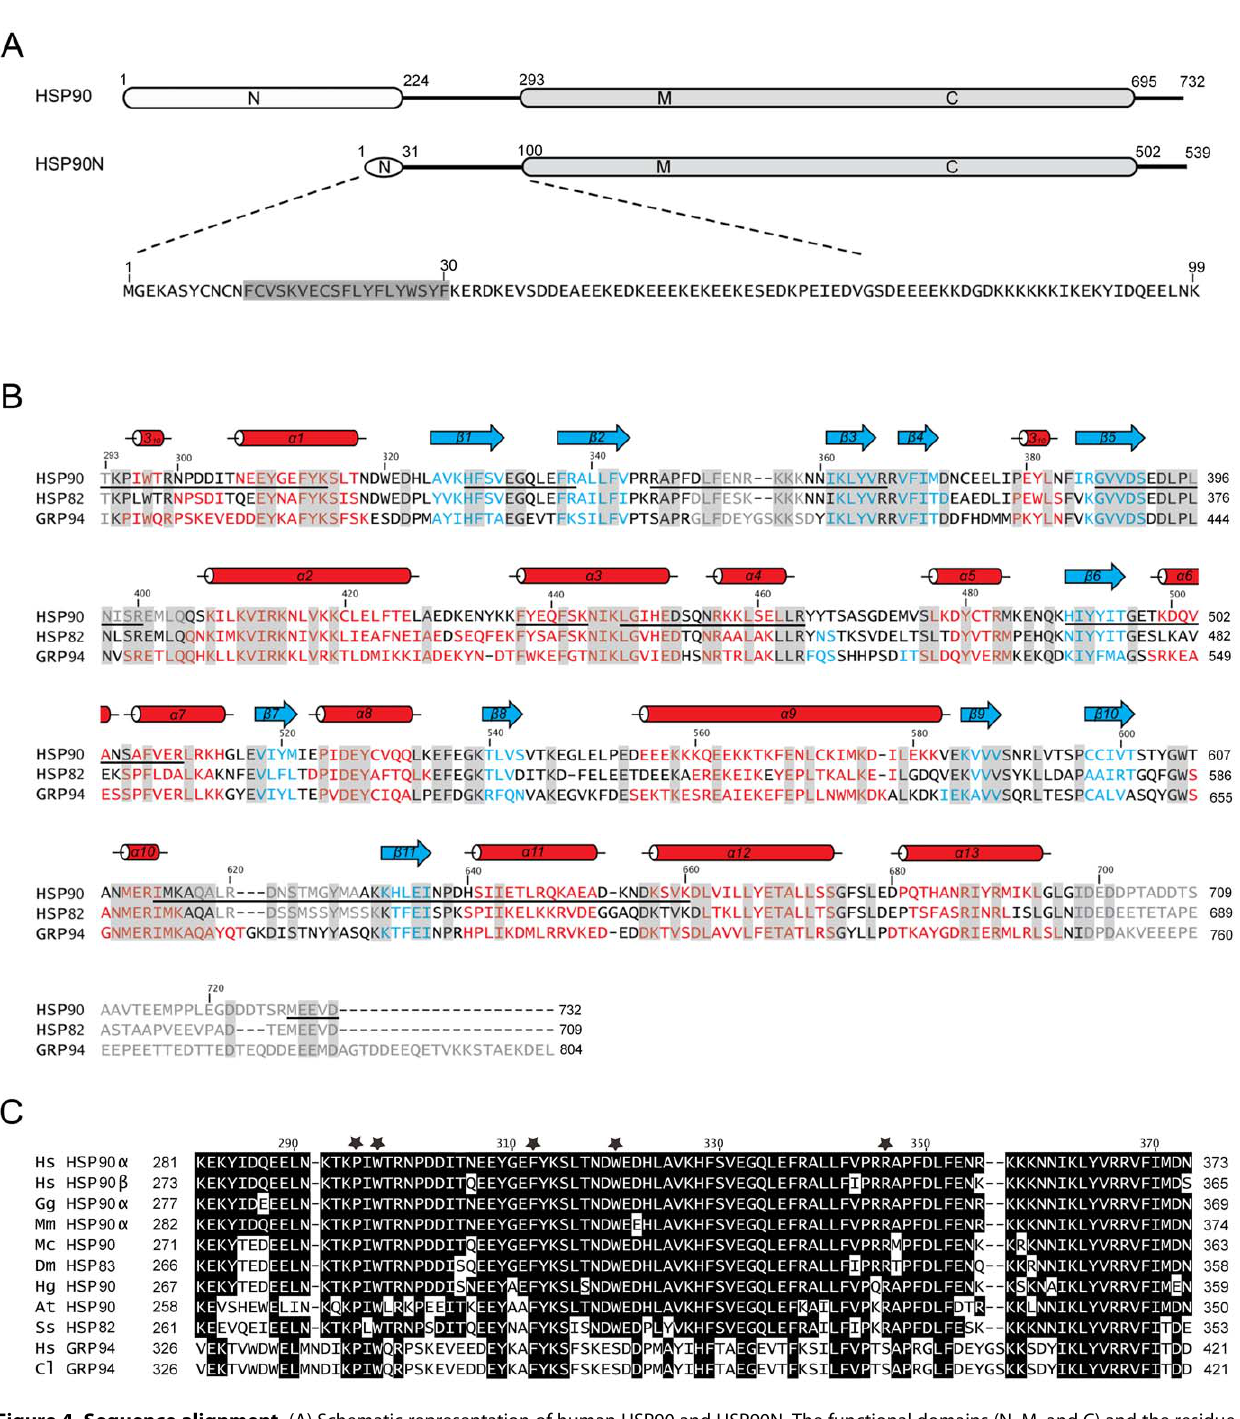
Figure 4. Sequence alignment. (A) Schematic representation of human HSP90 and HSP90N. The functional domains (N, M, and C) and the residue number are indicated. The N-terminal sequence (residues 1–99) of HSP90N is shown below and a predicted transmembrane helix is highlighted in gray. (B) Structure-based sequence alignment of the MC domains of human HSP90, yeast HSP82 (PDB: 2CG9) and canine GRP94 (PDB: 2O1V). Residues of a -helices, b -strands, and disorders are shown in red, blue, and gray, respectively, and those of identical residues are highlighted by gray boxes. The secondary structural elements according to the human HSP90 structure are shown above the sequences, and the bars under the HSP90 sequence indicate the segments which have been identified by MALDI-MS analysis. Two extra Ala residues at the N-terminus and the C-terminal His-tag also have been identified, but are not shown in the figure. (C) Part of the M domain sequence from human HSP90 is aligned with other 90-kDa heat shock proteins of Homo sapiens (Hs), Gallus gallus (Gg), Mus musculus (Mm), Macrocentrus cingulum (Mc), Drosophila melanogaster (Dm), Heterodera glycines (Hg), Arabidopsis thaliana (At), Saccharomyce scerevisiae (Ss) and Canis lupus (Cl) for the regions near the W320 binding site. The residues involved in M domain interaction in the human MC-HSP90 hexamer are marked with black stars.